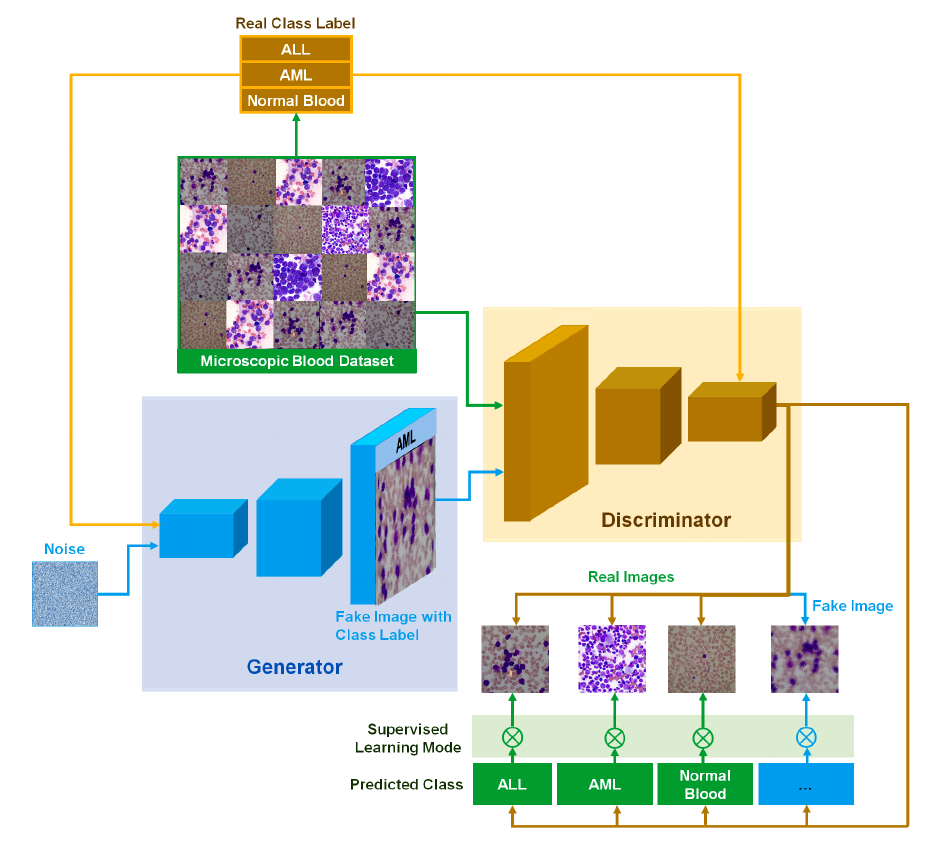
Figure 3. Workflow of our developed GAN classifier for identifying acute leukemias and normal cases from microscopic blood